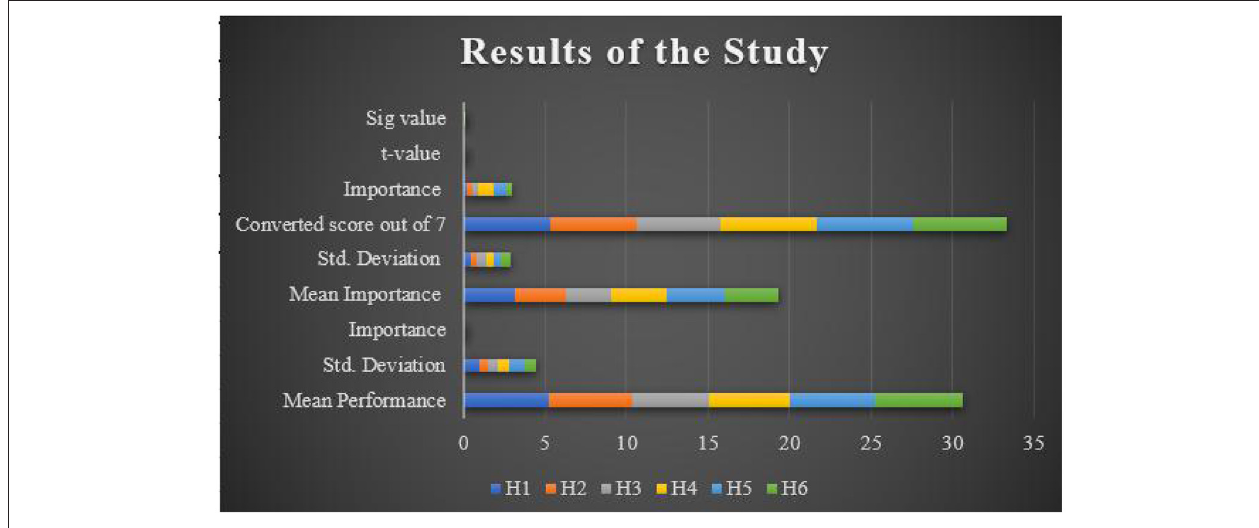
FIGURE 5 | Assessing the measures.